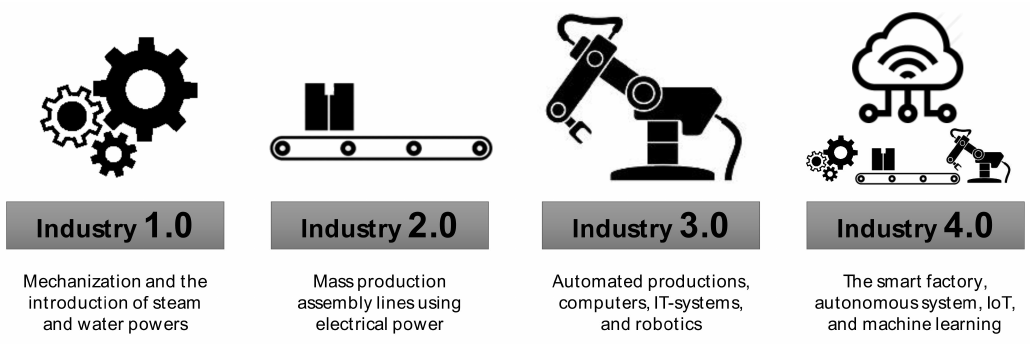
Figure 1. An outline of the industrial